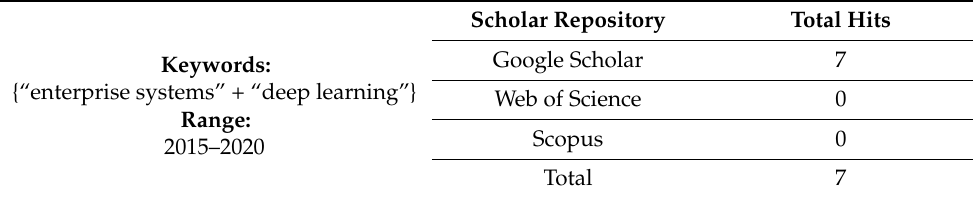
Table 3. Returned search hit counts with keyword {“enterprise systems” + “deep learning”} between